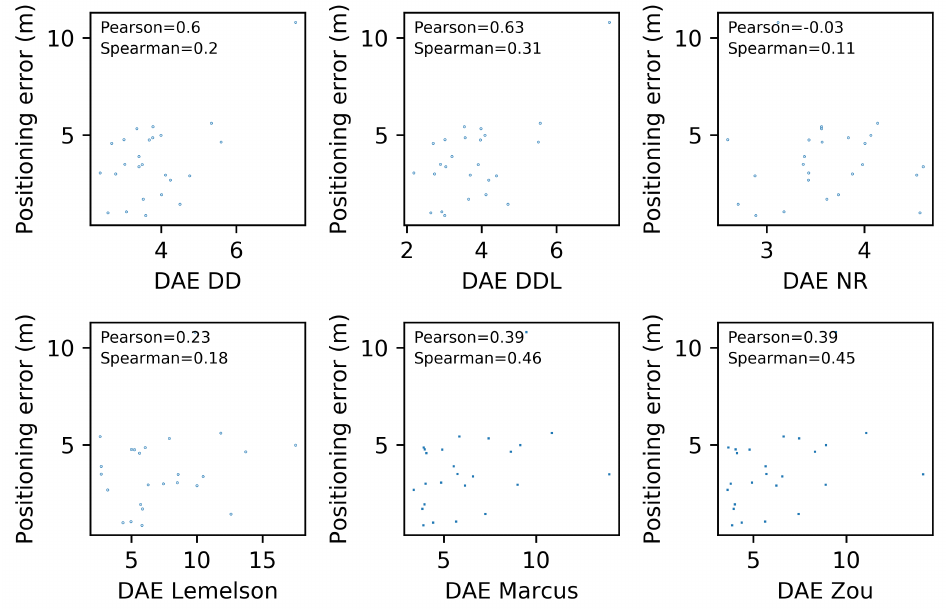
Figure 24. Scatterplots for five DAE methods and one baseline, depicting the DAE estimates against the actual positioning error values. Pearson’s correlation coefficient as well as Spearman’s rank correlation coefficient are indicated for each method. The validation set of the MAN dataset is